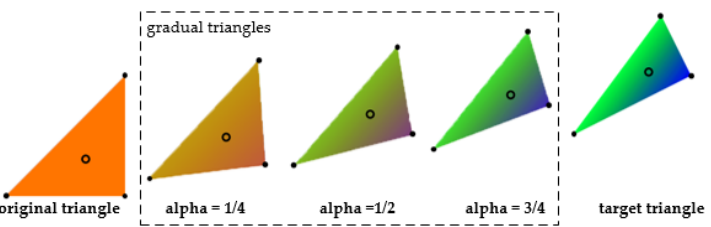
Figure 4. Demonstration of the transition from one tri angle to another.